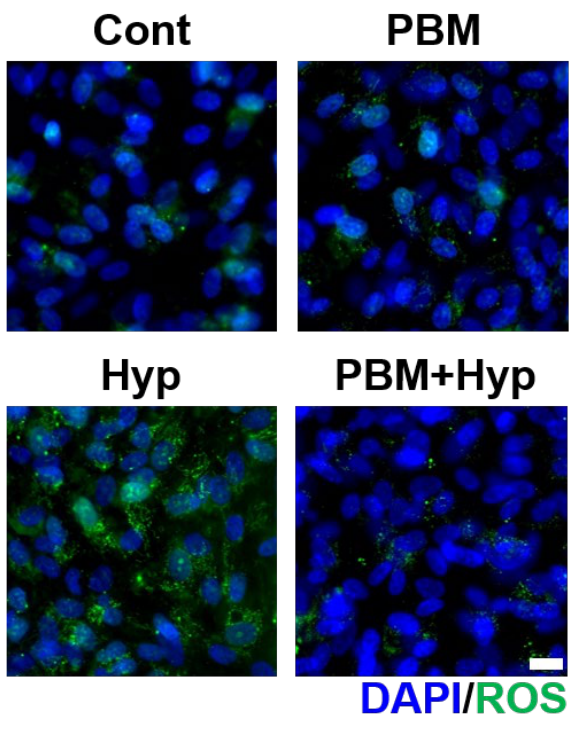
Figure 5. Effect of PBM on ROS generation. Immunofluorescence image of ROS. Scale: 20 µ m. Cont: control model, PBM: PBM-treated model, Hyp: hypoxia model, PBM+Hyp: hypoxia model with pre-treatment with PBM.